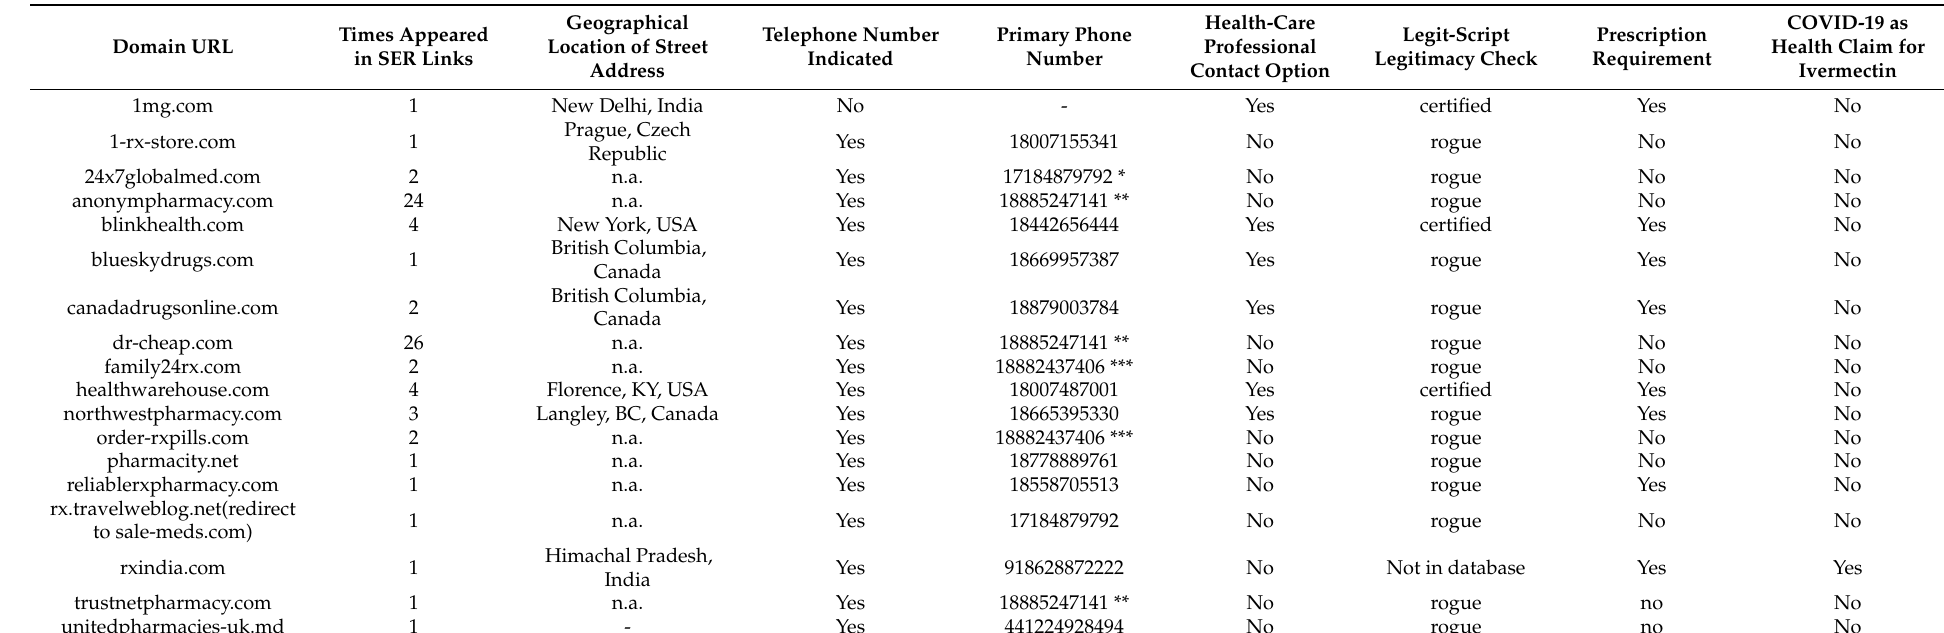
Table A1. Potential indicators of patient safety risks of the evaluated online pharmacy websites